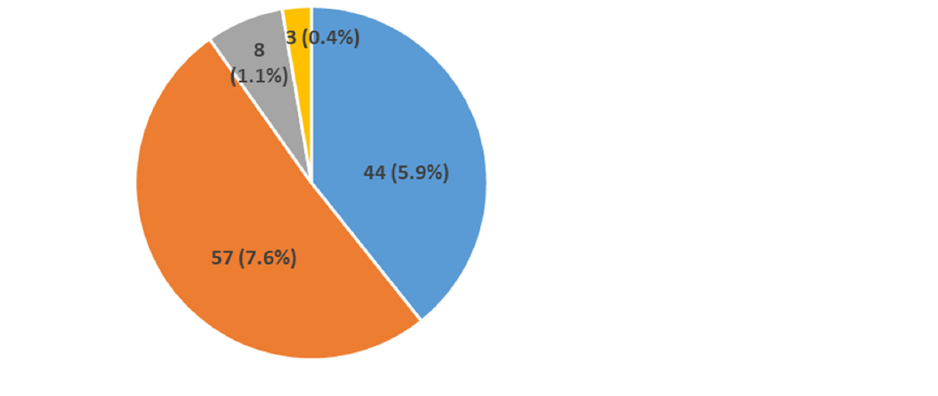
Figure 4. Distribution of point mutations in DMD (red) or BMD (blue) analyzed patients.